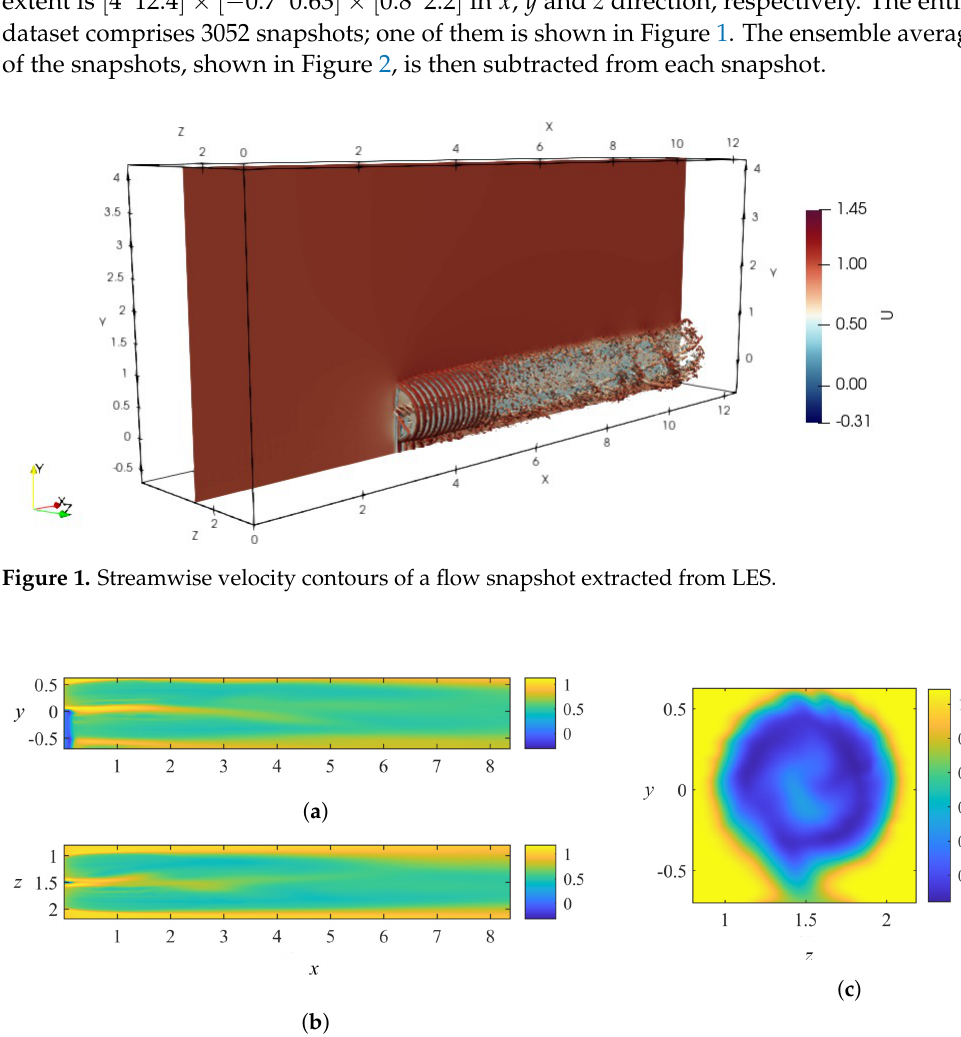
Figure 2. Streamwise velocity contours of the snapshots’ ensemble mean. ( a ) x − y plane at z = 1.5. ( b ) x − z plane at y = 0 . ( c ) z − y plane at x =